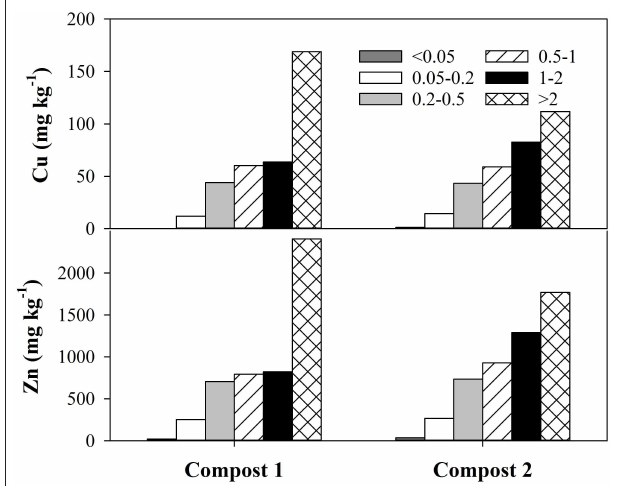
FIGURE 1 | Contribution (mg kg − 1 ) of each particle size fraction to the total Cu and Zn concentrations in the composts (concentration in the fraction × proportion of the fraction in the